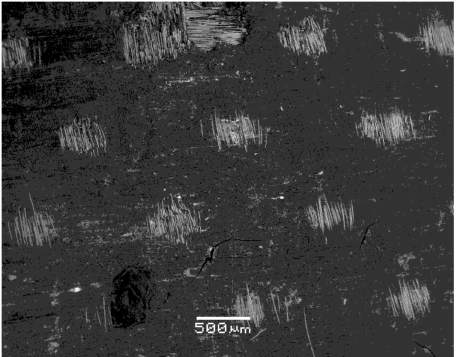
Figure 12. SEM image of the surface of the textolite material with strong degradation effects (30 times magnification). There is a large amount of charring and melting of the resin visible in the top layer of the material and numerous bundles of bright fibres of the textile support on the surface. There were also single large cracks in the resin.